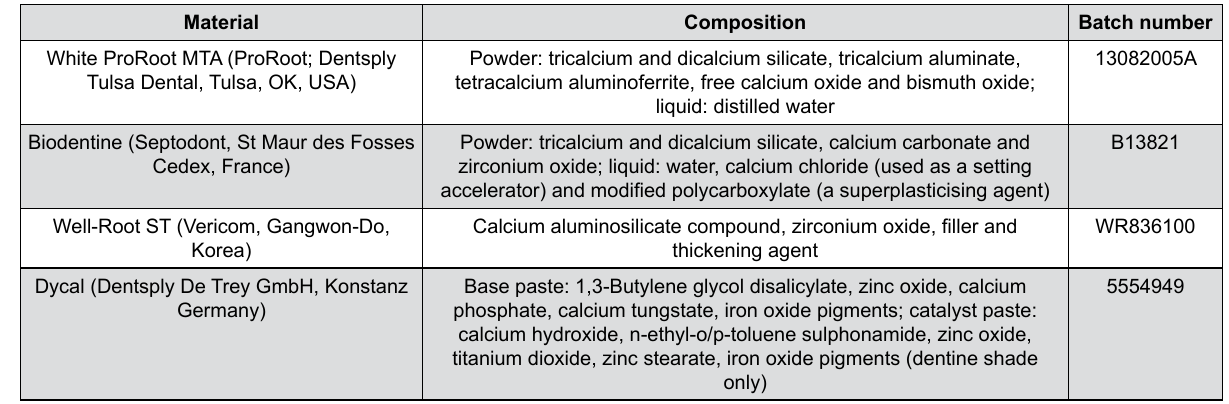
Figure 1- Composition description and batch numbers of the tested